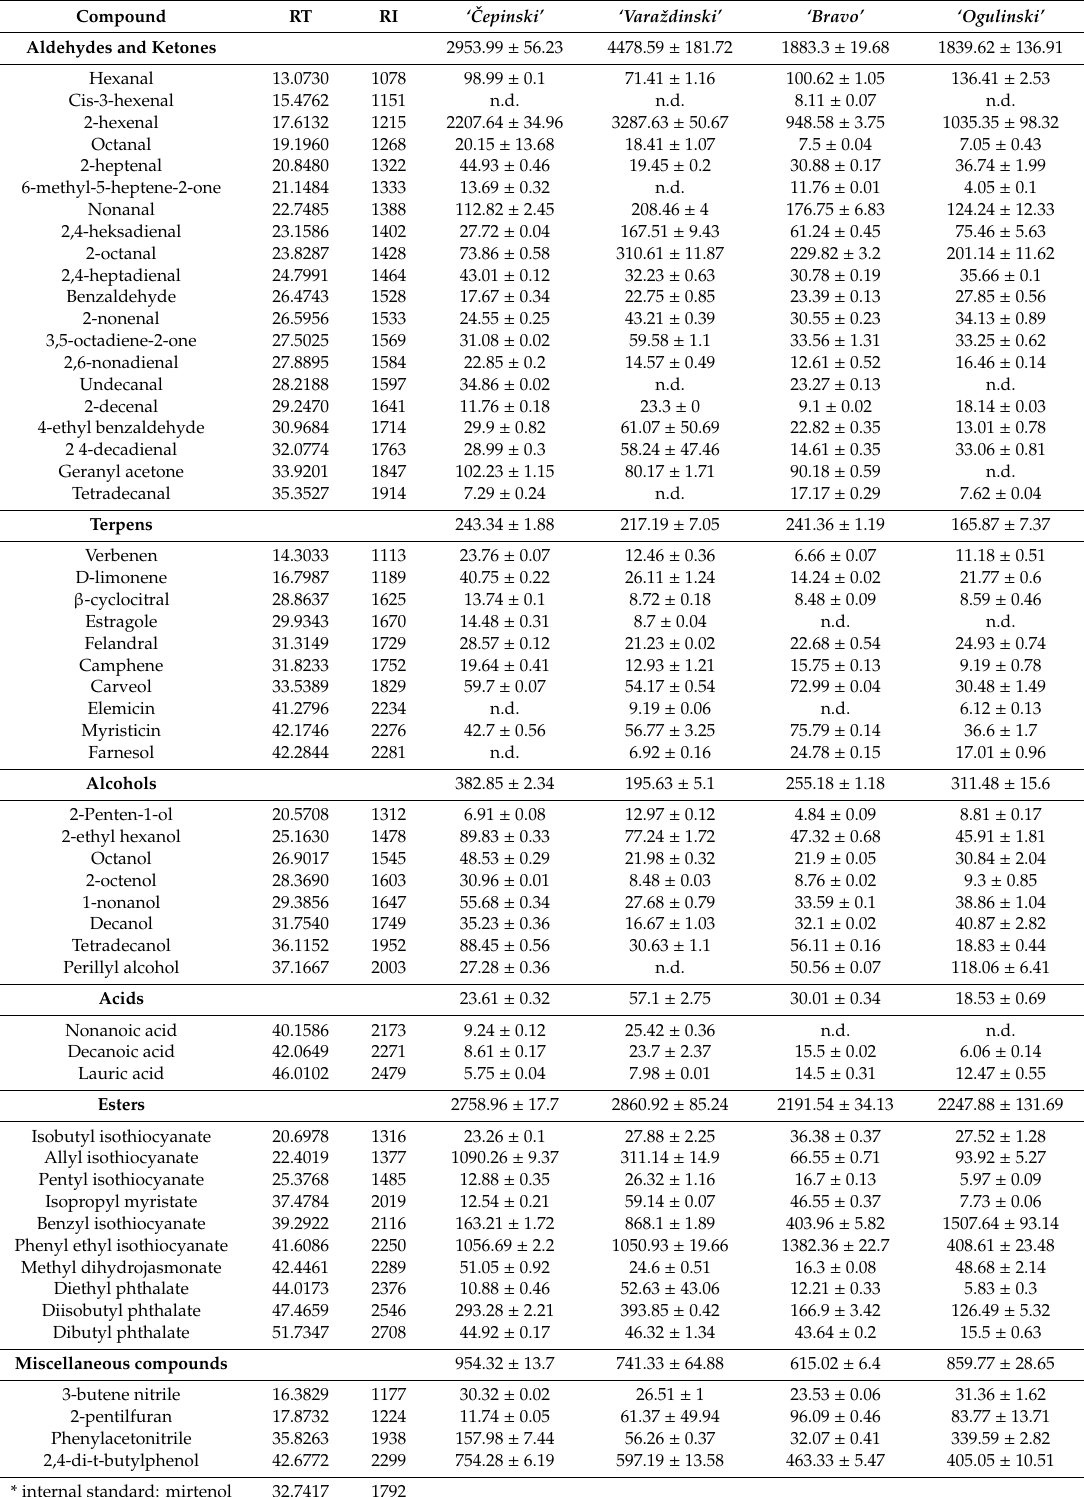
Table 4. Aromatic profile ( µ g / L) of cabbage cultivars ( ‘ ˇCepinski’ , ‘Varaždinski’ , ‘Bravo’ , ‘Ogulinski’ ). Compound RT RI ‘ ˇCepinski’ ‘Varaždinski’ ‘Bravo’ ‘Ogulinski’ Aldehydes and Ketones 2953.99 ± 56.23 Hexanal